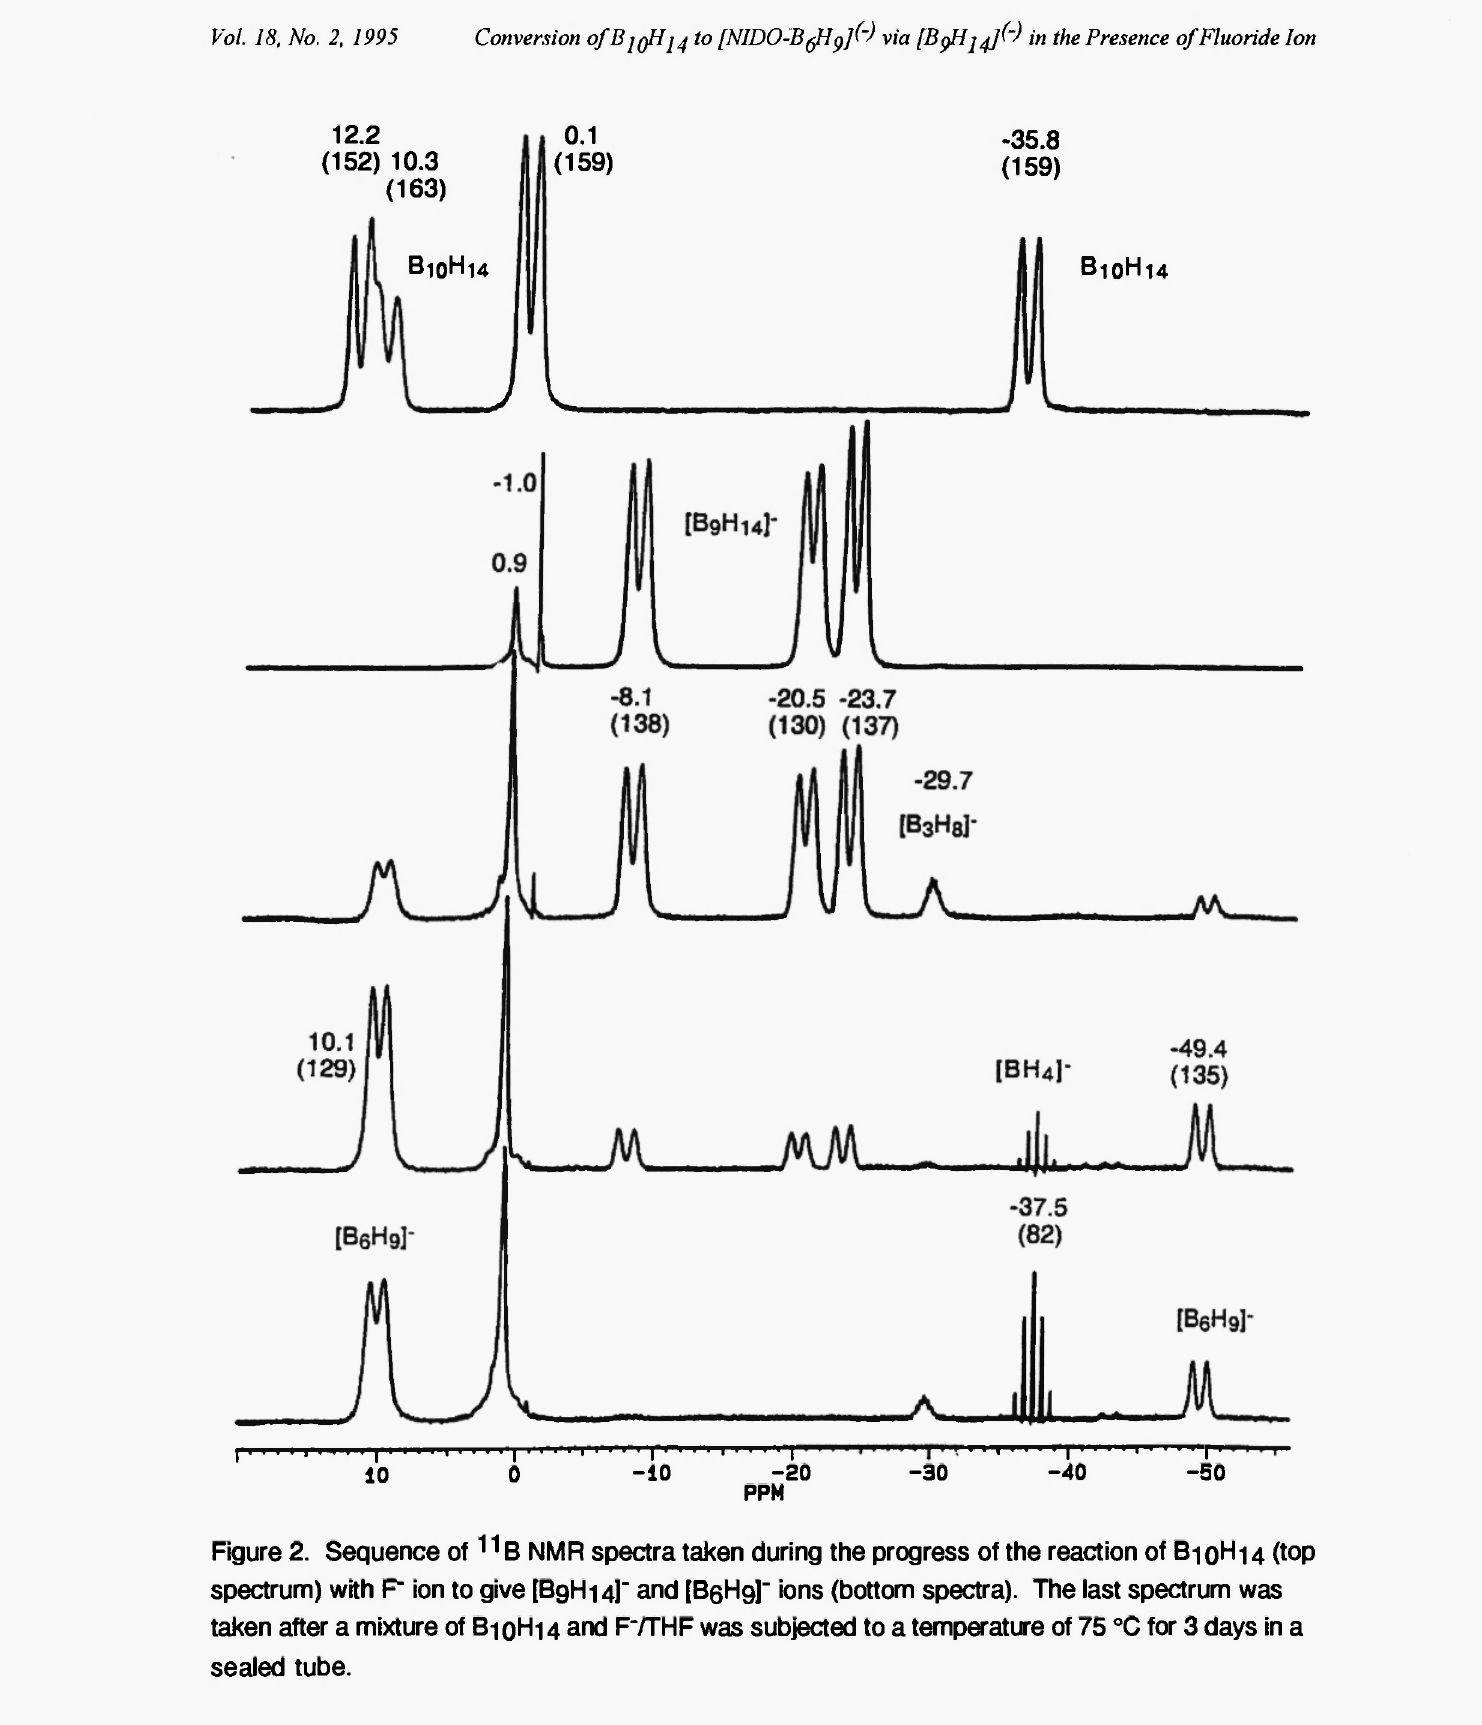
Figure 2. Sequence of 11 Β NMR spectra taken during the progress of the reaction of Bi 0H14 (top spectrum) with Ρ ion to give [B9H14]" and [BßHg]" ions (bottom spectra). The last spectrum was taken after a mixture of B-| 0H14 and FVTHF was subjected to a temperature of 75 °C for 3 days in a sealed